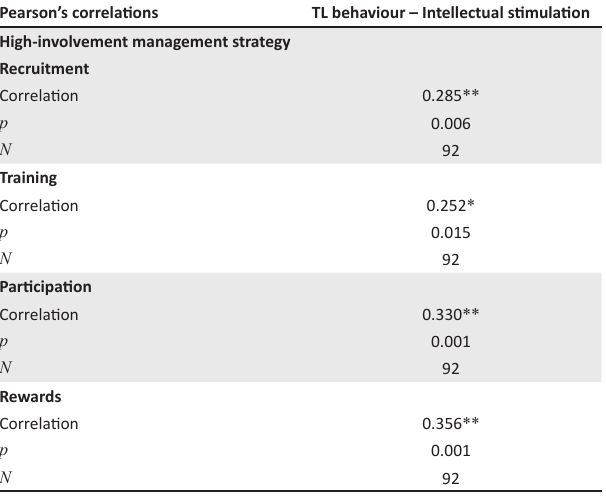
TABLE 5: Correlations of transformational leadership behaviour – Intellectual stimulation and high-involvement management strategy. Pearson’s